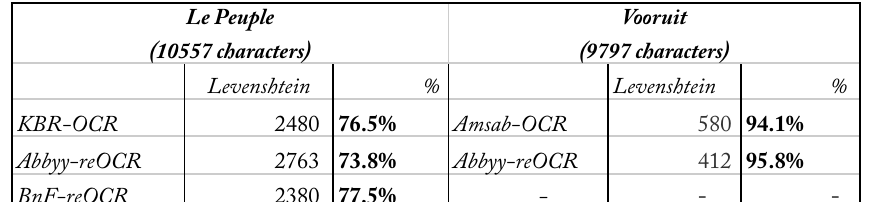
Table 1 An assessment of the accuracy of existing (KBR-OCR and Amsab-OCR), and newly generated OCR by Transkribus (Abbyy-reOCR and BnF-reOCR), for two Belgian historical newspapers Le Peuple (French) and Vooruit